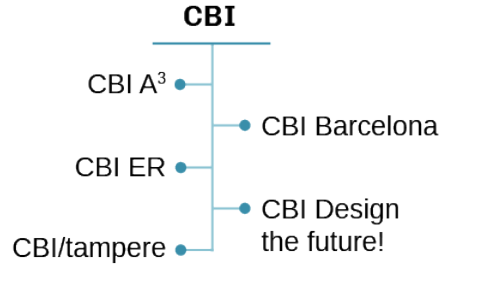
Fig. 2. CBI programmes that took place in